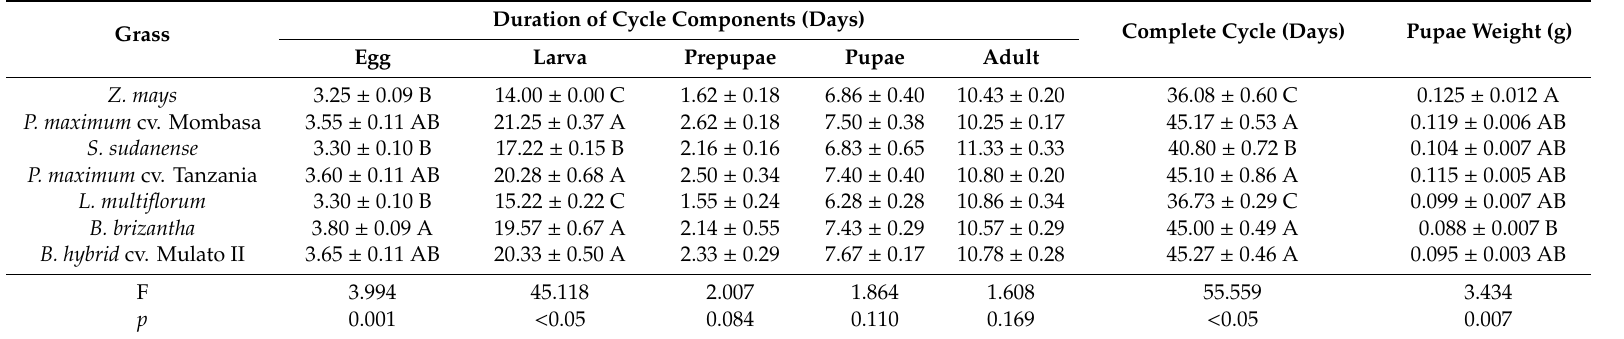
Table 4. Duration (mean ± SEM) of development stages and pupae weights (mean ± SEM) of S. frugiperda in the grasses.